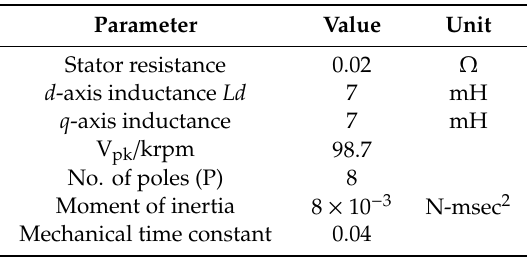
Figure 4. Control of the wind turbine (WT) boost converter interfacing DC microgrid. Table 2. PMSG parameters [29].